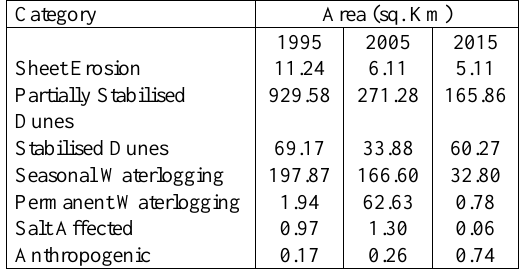
Table 1. Area statistics of degraded land categories over the years.